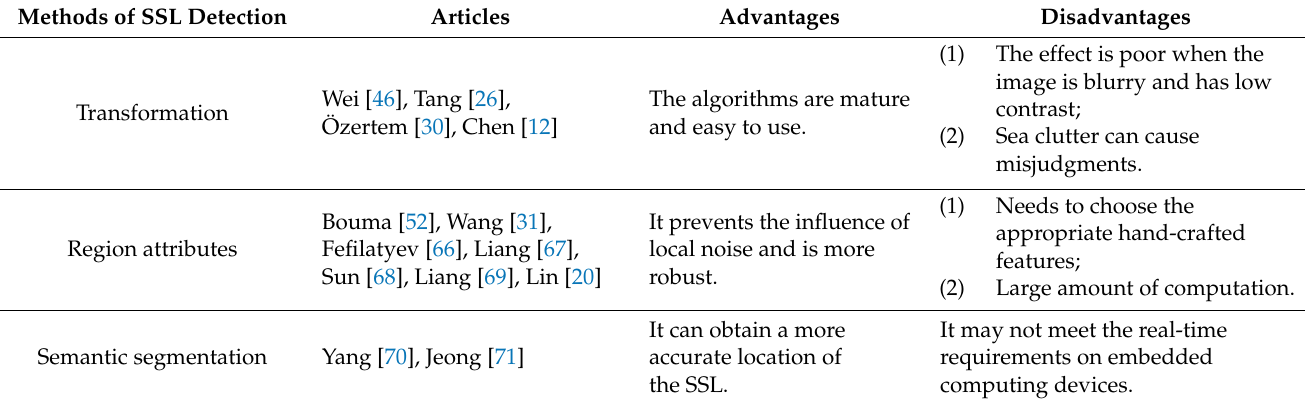
Table 3. Summary of the sea–sky line detection